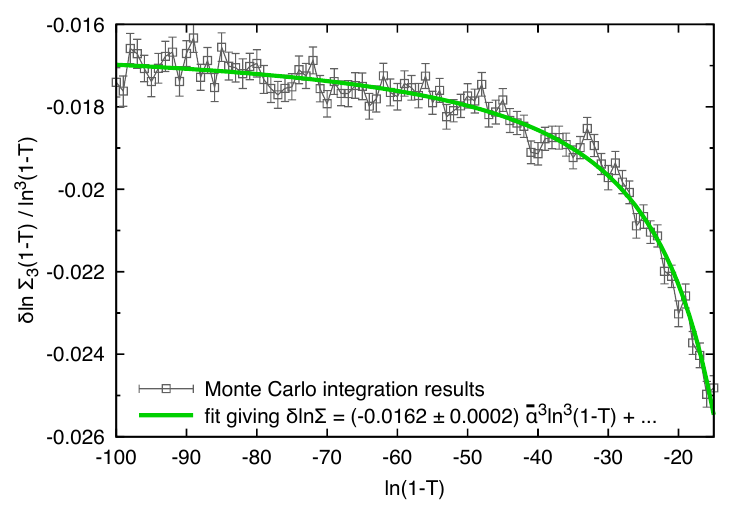
Figure 1 . Evaluation of (cid:14) ln (cid:6) 3 (de(cid:12)ned here as the coe(cid:14)cient of (cid:22) (cid:11) 3 rather than (cid:11) 3 the text) for the thrust, T , as a function of ln(1 (cid:0) T ), within the approximation of eqs. (B.7){(B.12) of ref. [1], and divided by ln 3 (1 (cid:0) T ) to help visualise the coe(cid:14)cient of (cid:22) (cid:11) 3 ln 3 (1 (cid:0) T ). The (cid:12)t function assumes a form for (cid:14) ln (cid:6) 3 that is a third-order polynomial in powers of ln(1 (cid:0) T ). The corresponding result for the coe(cid:14)cient of (cid:22) (cid:11) 3 L 3 in table 1 displays a larger, somewhat conservative